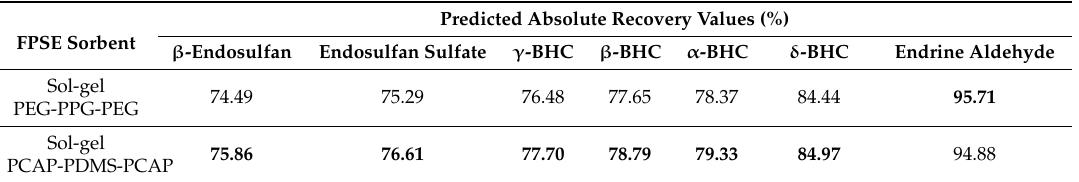
Table 1. Predicted absolute recovery values (%) for selected OCPs on two FPSE media. Predicted Absolute Recovery Values FPSE Sorbent